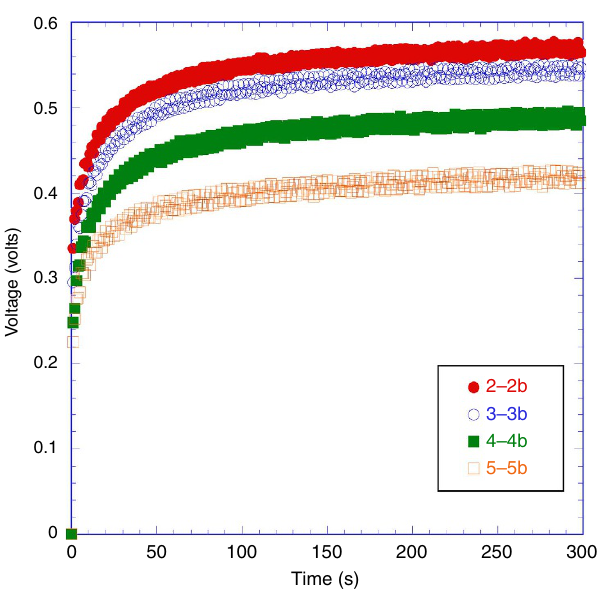
Figure 4 | Development of voltage across the film/substrate interface. The voltage drop measured between the film surface and the back surface of the substrate at four positions on a sample when an in-plane current of 5 (cid:4) 10 (cid:3) 5 Amps is imposed between electrodes 1 and 7 (see Fig. 1 for electrode configuration). The legend denotes the pairs of top/bottom electrodes used for each measurement. Measurements were taken at 370 (cid:2) C, with the sample equilibrated at p O 2 ¼ 1.5 torr.